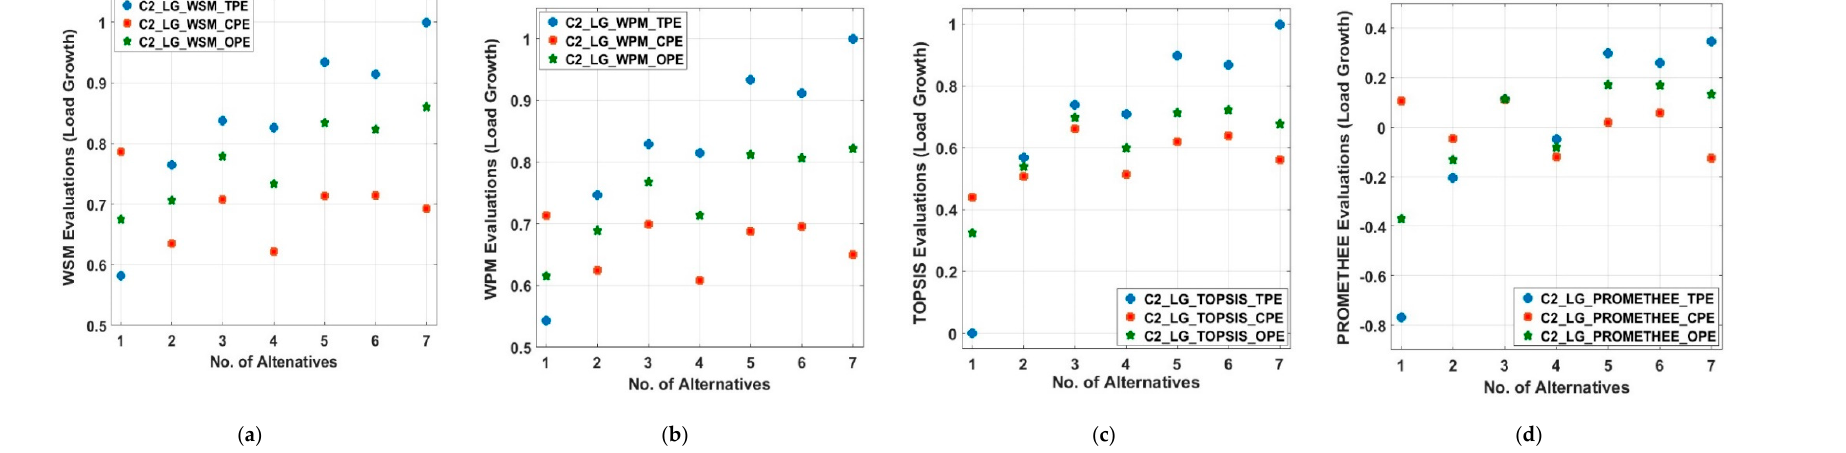
Figure 10. MCDM evaluations for C2_LG in 33-bus MDN: ( a ) WSM scores; ( b ) WPM scores; ( c ) TOPSIS scores; ( d ) PROMETHEE scores. Table 16. Order of the ranks across TPE, CPE, and OPE in C2_LG for 33-bus MDN.